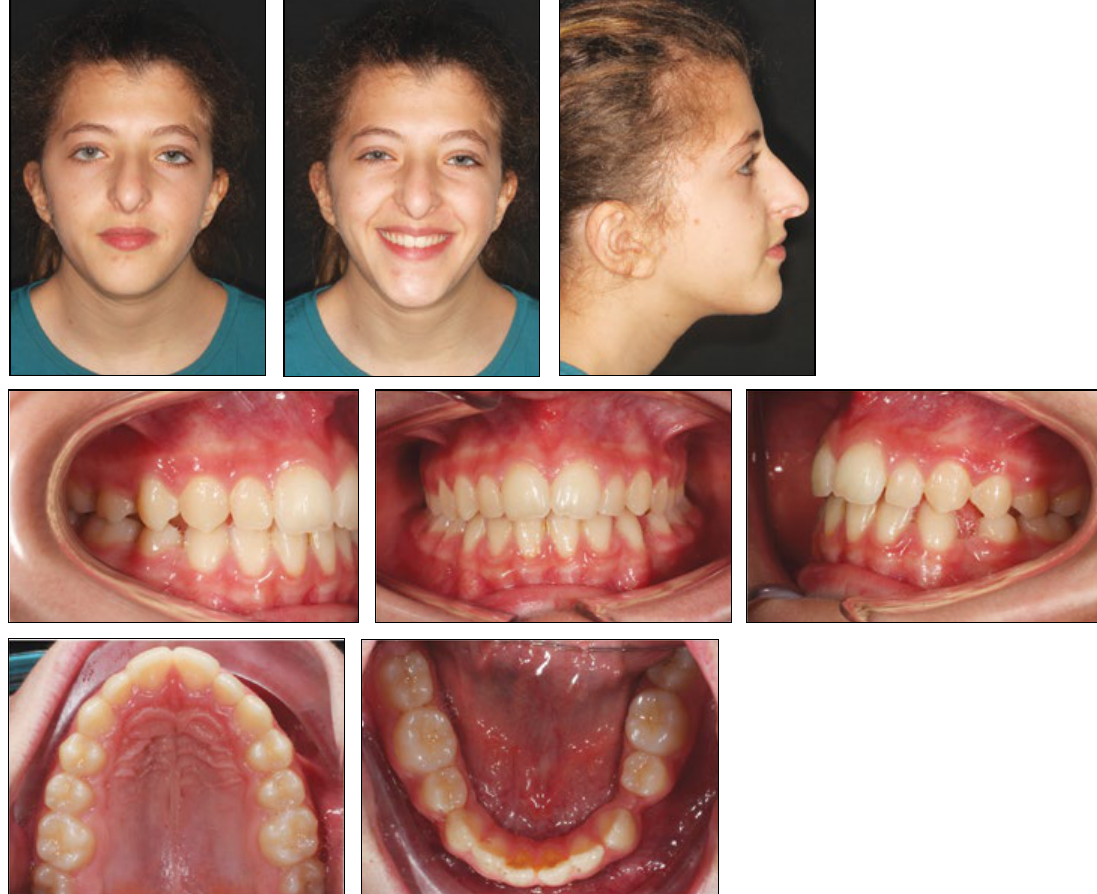
Figure 3. Post-treatment facial and intraoral